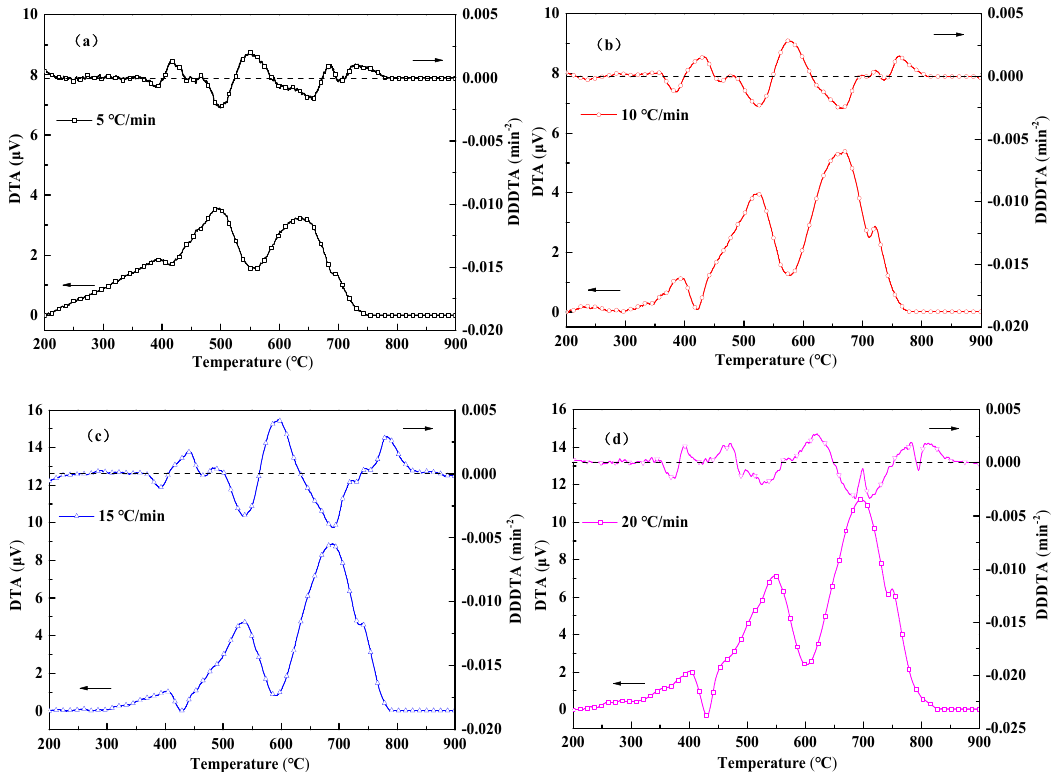
Figure 10. Fractional conversion and reaction rate-conversion curves of the sintered mixture at different heating rates.